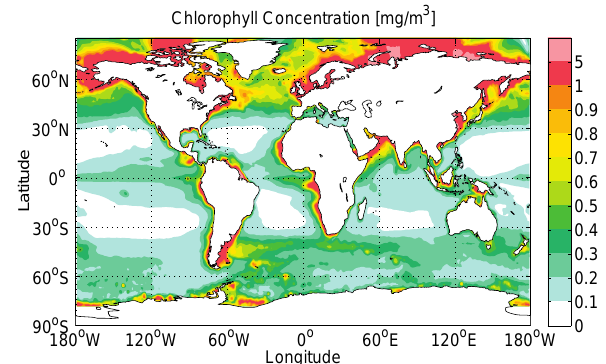
Fig. 12. Annual mean chlorophyll concentration (mgm − 3 ) clima- Fig. 112. Annual mean Chlorophyll concentration ( mgm (cid:0) 3 ) clima- tology. Clear waters are mainly in the subtropical basins and high tology. Clear waters are mainly in the subtropical basins and high chlorophyll concentration is seen in regions with high level of bio- Chlorophyll concentration is seen in regions with high level of bio- logical activity. The data are from Sweeney et al. logical activity. The data are from Sweeney et al. (2005).